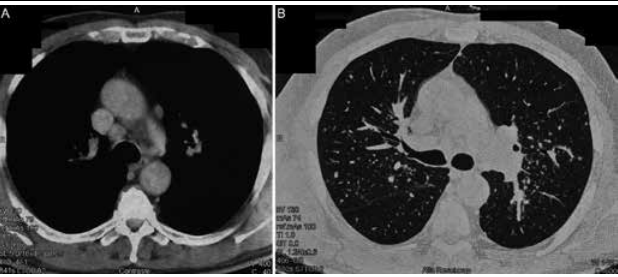
figurE 3 – Thoracic computed tomography showing mediastinal adenomegaly, multiple pulmonary nodules and micronodules